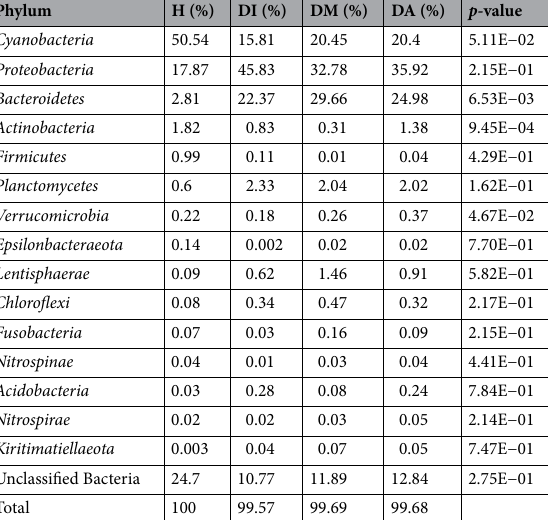
Table 2. The relative frequency of the major phyla of Bacteria (calculated with ANOVA) associated with healthy corals (H) and initial (DI), intermediate (DM), and advanced (DA) stages of tissue necrosis, and the p -value.